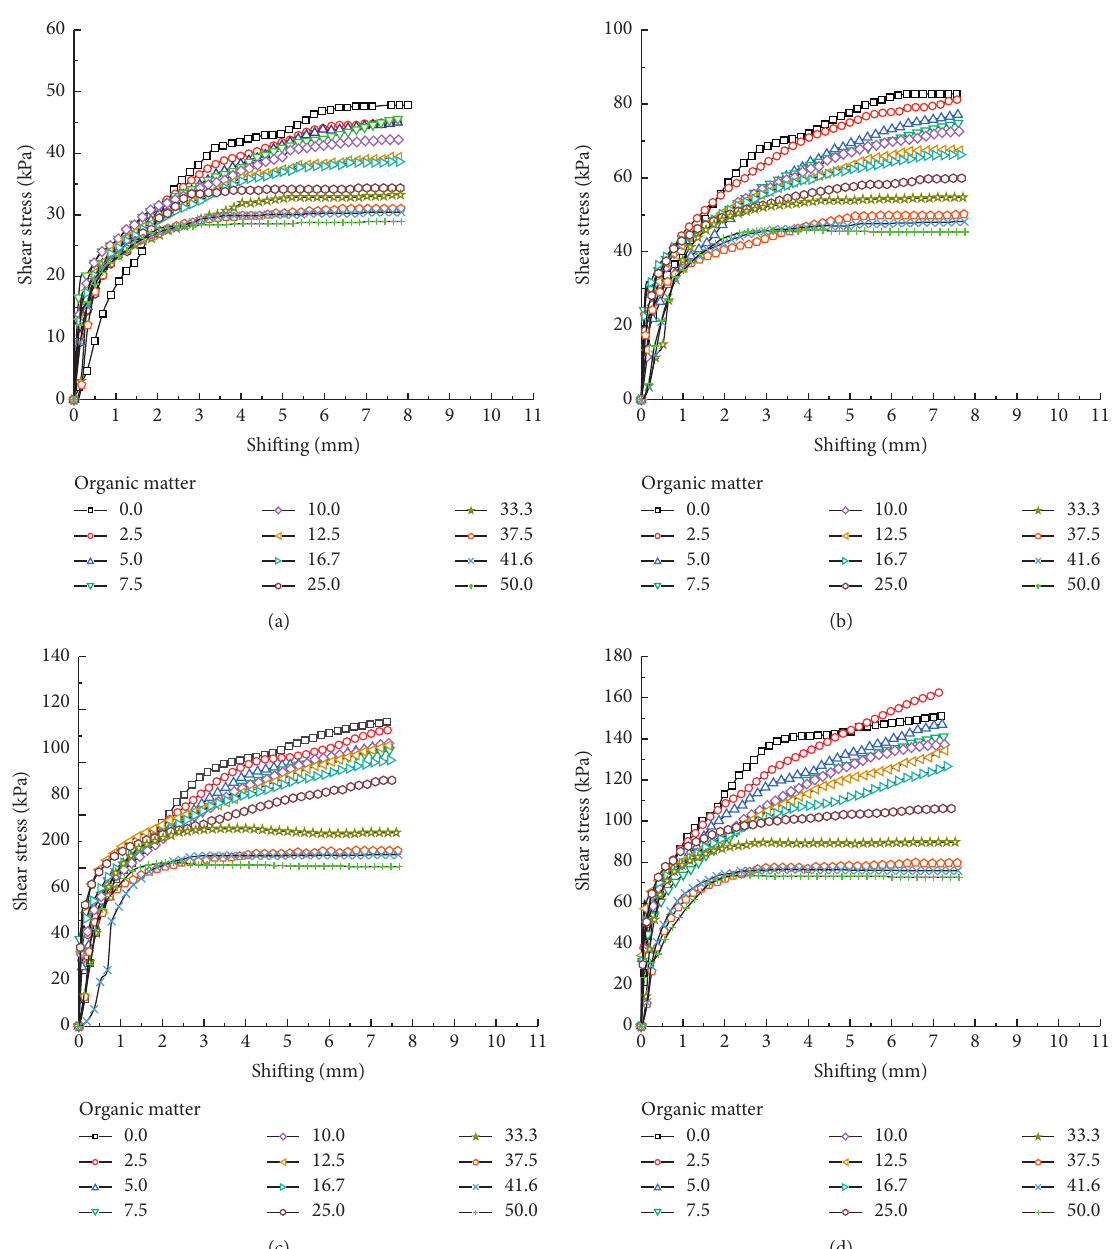
Figure 8: Shear strength and shear displacement curves of 12 groups of samples under different vertical pressures. (a) The prepressure is 50kPa. (b) The prepressure is 100kPa. (c) The prepressure is 150kPa. (d) The prepressure is 200